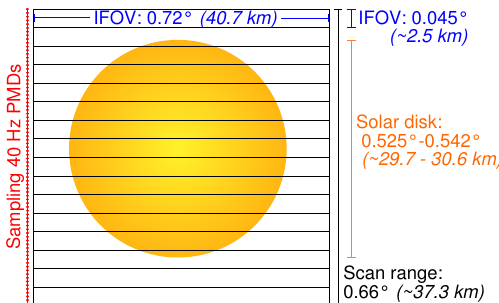
Fig. 3. SCIAMACHYs instantaneous field of view (IFOV) com- pared to the solar disk, detailed explanation is given in the text. The red points on the left side indicate the sampling of the PMDs during one